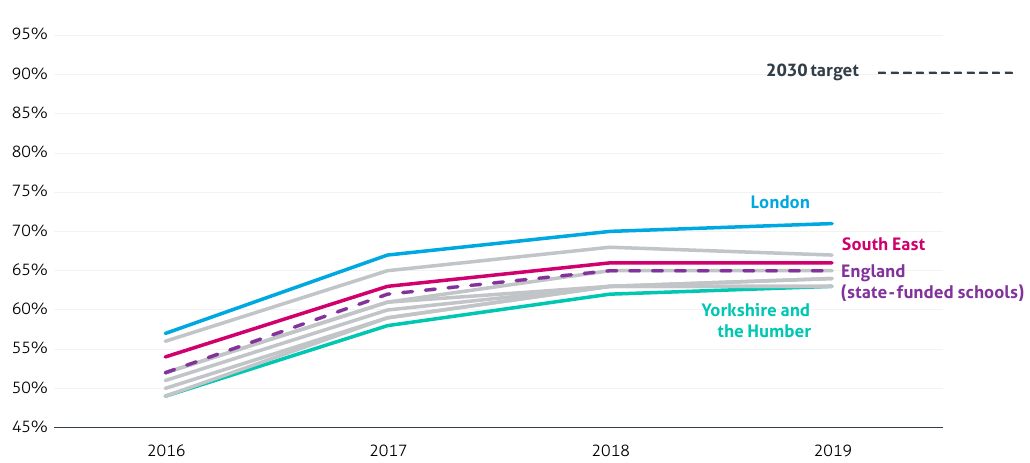
Figure 3 Percentage of pupils reaching the expected standard in Key Stage 2 reading, writing and